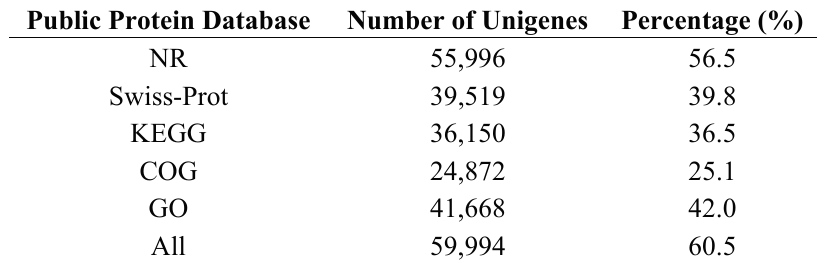
Table 2. Number of functional annotations for all unigenes in public databases.